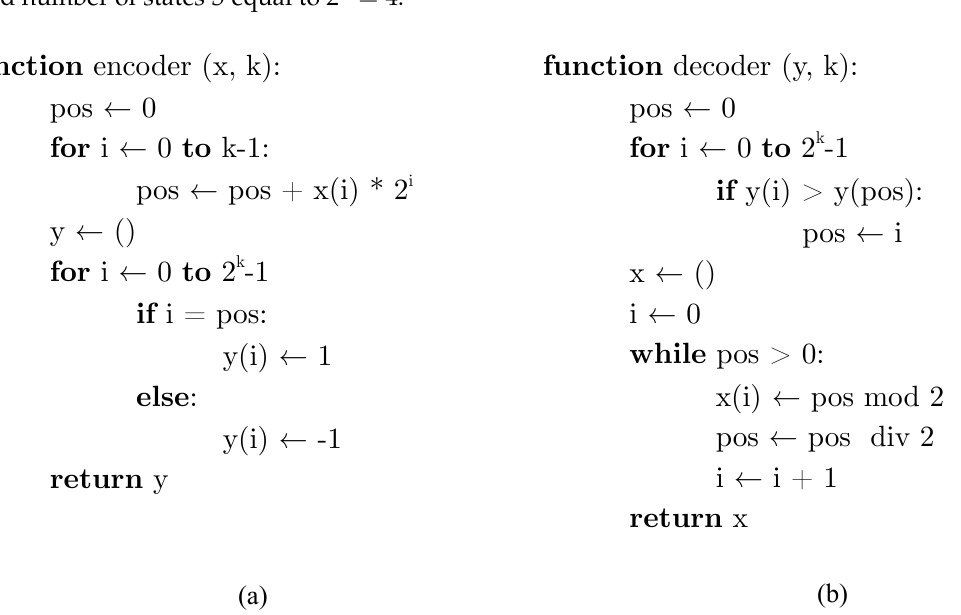
Figure 4. Pseudocode implementing the proposed scheme: ( a ) encoding and ( b ) decoding functions for a block of length k